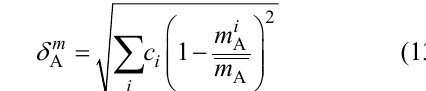
tolerance factor ( t ), electronegativity disorder parameter e δ ), ionic radius disorder parameter ( ( A mass disorder parameter ( Sample